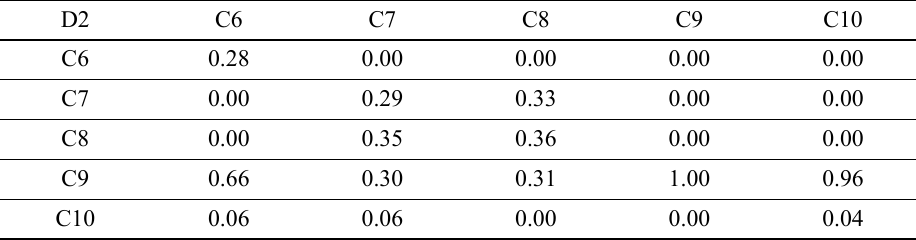
Table 7. The weight matrix of inner dependence for criteria under the Tactic